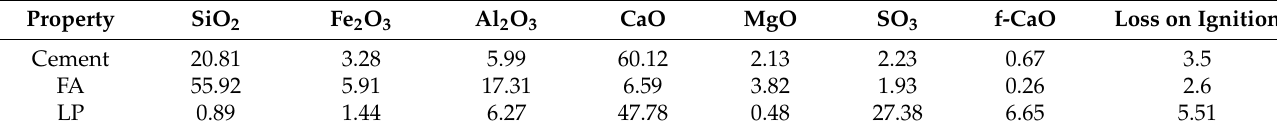
Table 2. Chemical compositions of cement, fly ash, and limestone powder.